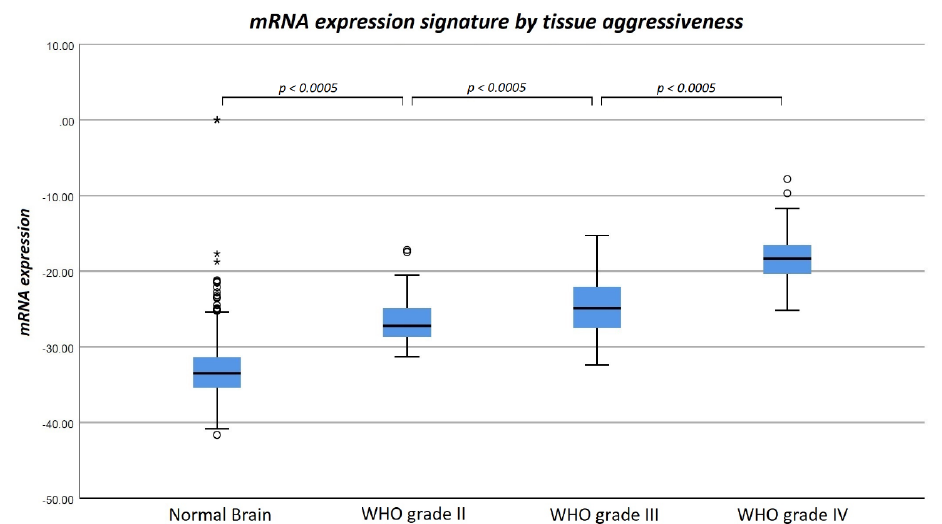
Figure 5. Boxplot diagram of mean mRNA expression signature of WHO grade II–IV gliomas as well as normal brain tissue. It is of note that mRNA expression signature shows a strictly monotonical increase with tissue aggressiveness. The observed differences were statistically significant between all subgroups.